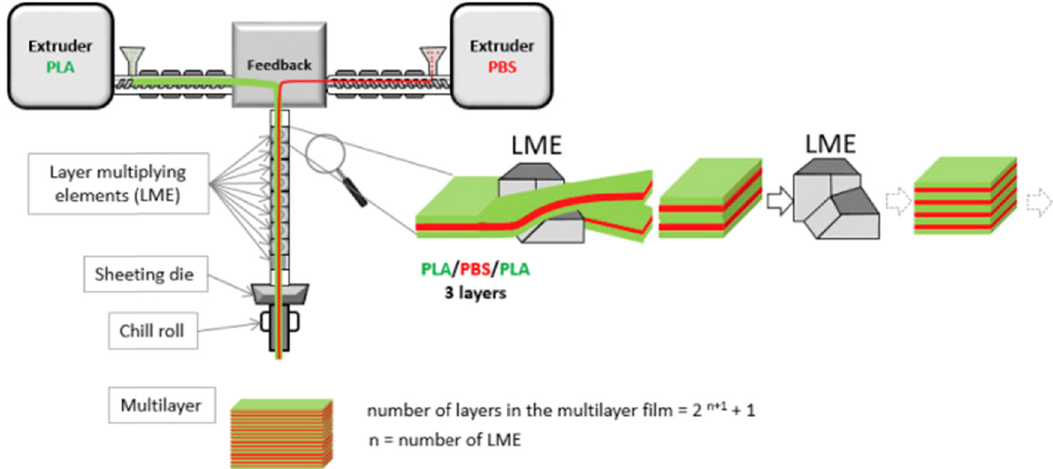
Figure 2: Schematic of the PLA/PBS polyester multilayer fi lm co - extrusion process ( 27 ) . Copyright 2020. Reproduced with permission from